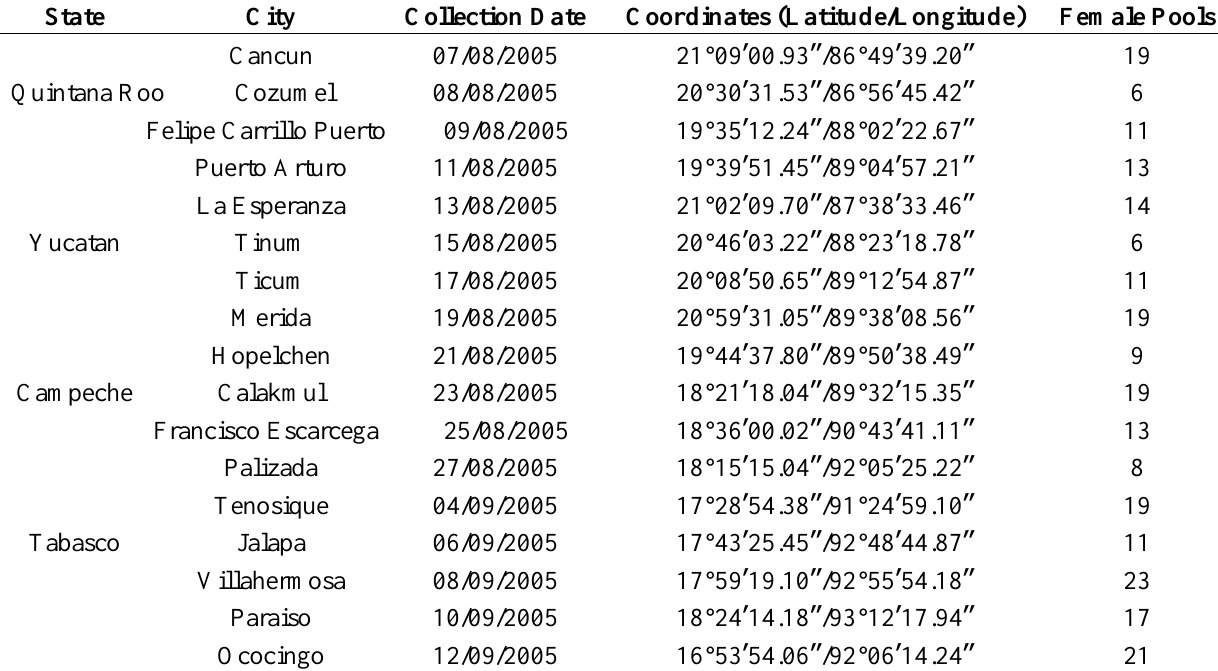
Table 1. Locations, dates of collections, global positioning system coordinates and sample sizes of Ae. aegypti collections in